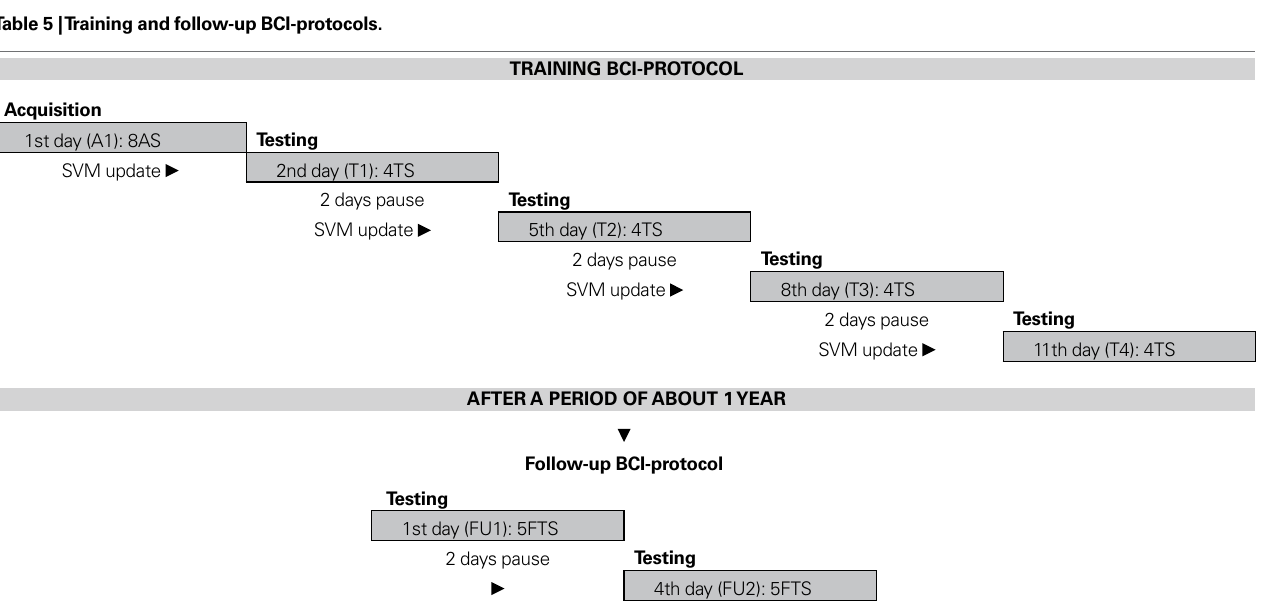
Table 5 | Training and follow-up